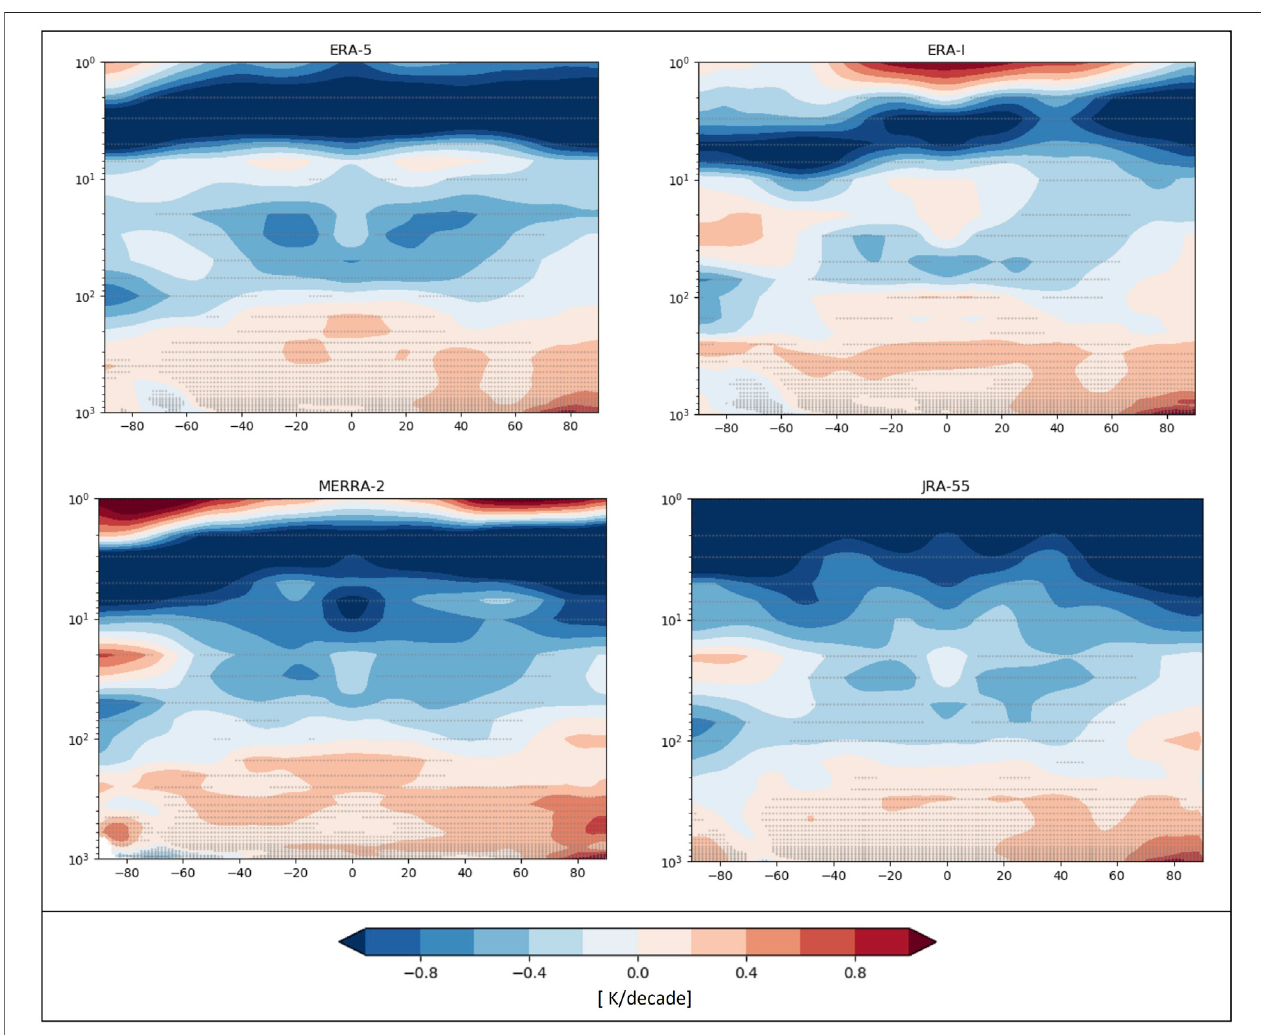
FIGURE 6 | Global zonal mean temperature trends [K/decade] of the period (1980-2018) for fi ve reanalyses and the RMME. Gray dots represent con fi dence intervals 95% (p-val ≤ 0.05) of the trends.